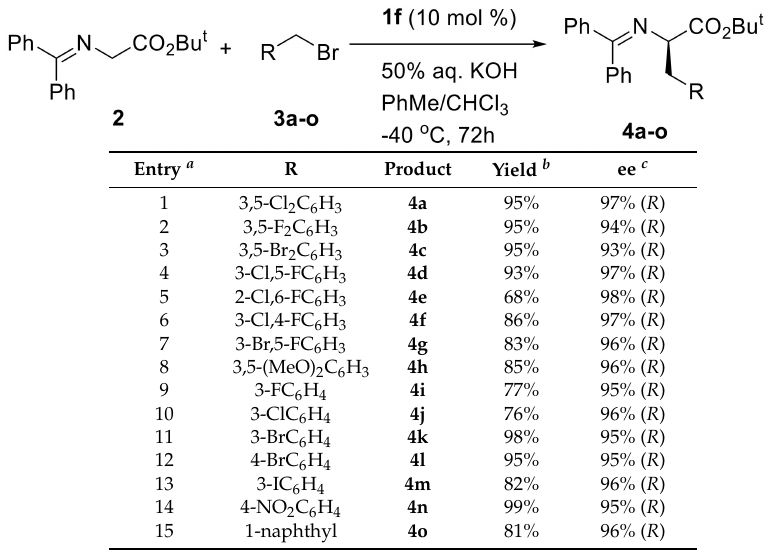
Table 2. Asymmetric alkylation of 2 with 3a-o under the catalysis of 1f .